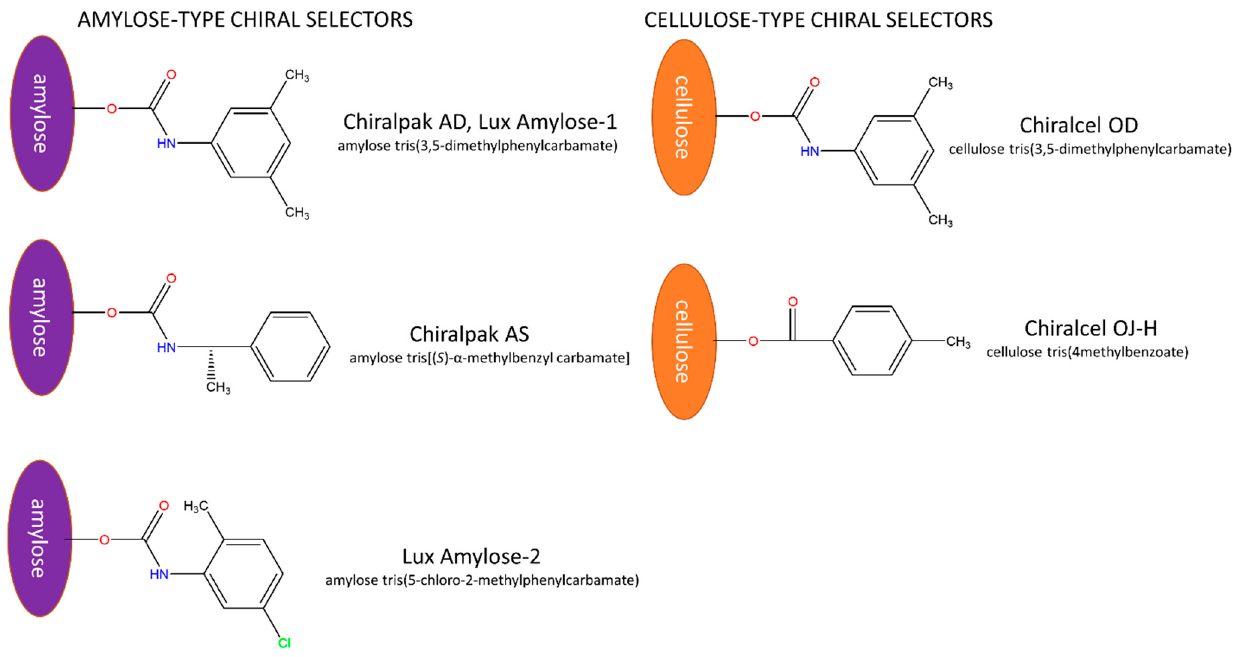
Figure 2. The structure of the chiral selectors .